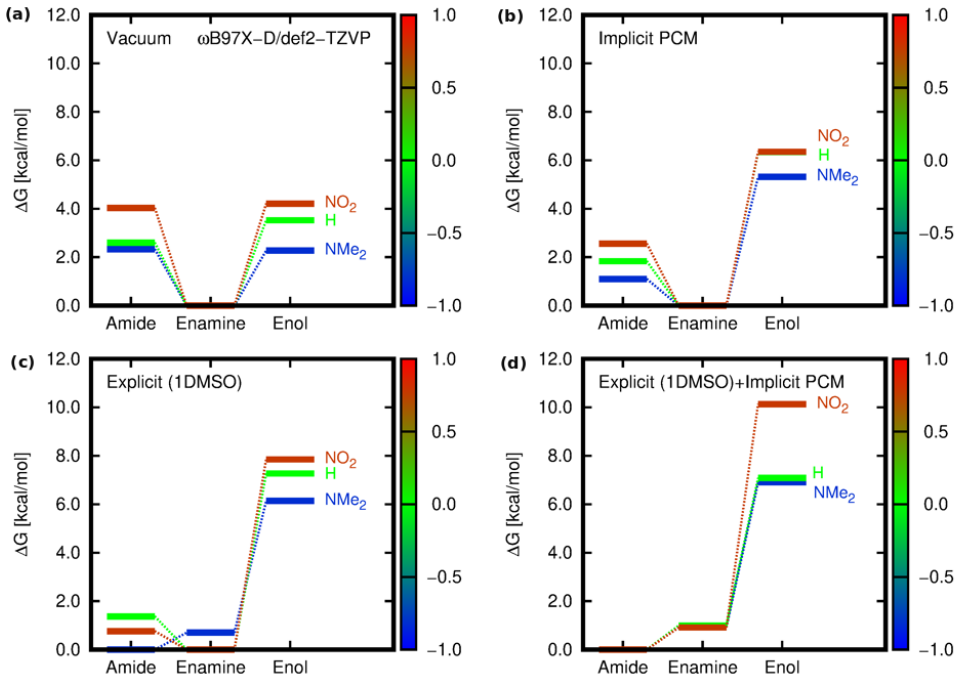
Figure 5. Relative Gibbs free energies for the tautomeric forms of 1 , 5 , and 10 [kcal/mol] estimated within the ω B97X-D/def2-TZVP approach for different environments: ( a ) isolated molecule in vacuum, ( b ) implicit solvent model (PCM) for DMSO, ( c ) explicitly included interaction of one solvent (DMSO) molecule with the analyzed derivative in vacuum, and ( d ) hybrid implicit (PCM)– explicit (DMSO) model (the color scale corresponds to the values of the Hammett constant of the substituent present in the phenyl